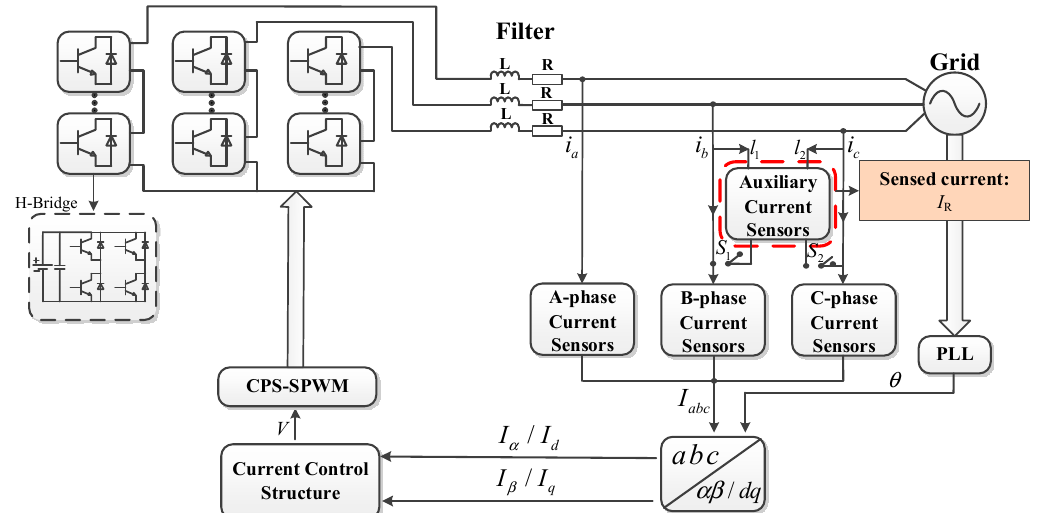
Figure 4. Physical circuit diagram containing the auxiliary sensor. Figure 5. Operating modes of the auxiliary current sensor. ( a ) Mode 1: Normal condition. ( b ) Mode 2: Calculation of B-phase sensor zero-offsets. ( c ) Mode 3: Calculation of C-phase sensor zero-offsets.